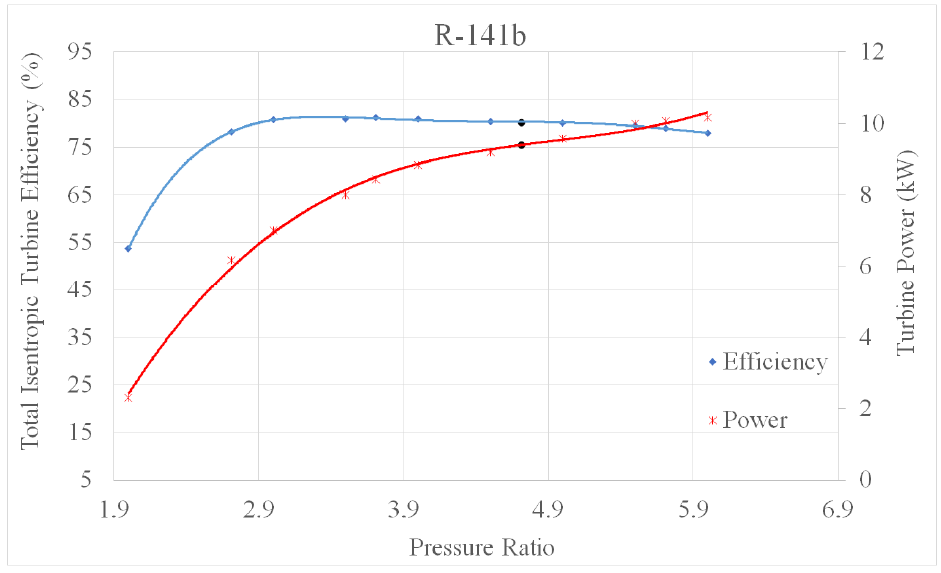
Figure 15. Variation in the total isentropic efficiency and power of the turbine operating with R-141b, as a function of pressure ratio.